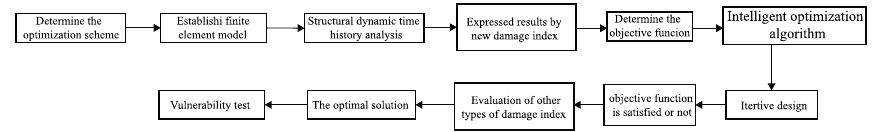
Fig. 19 Flow chart of structural optimization